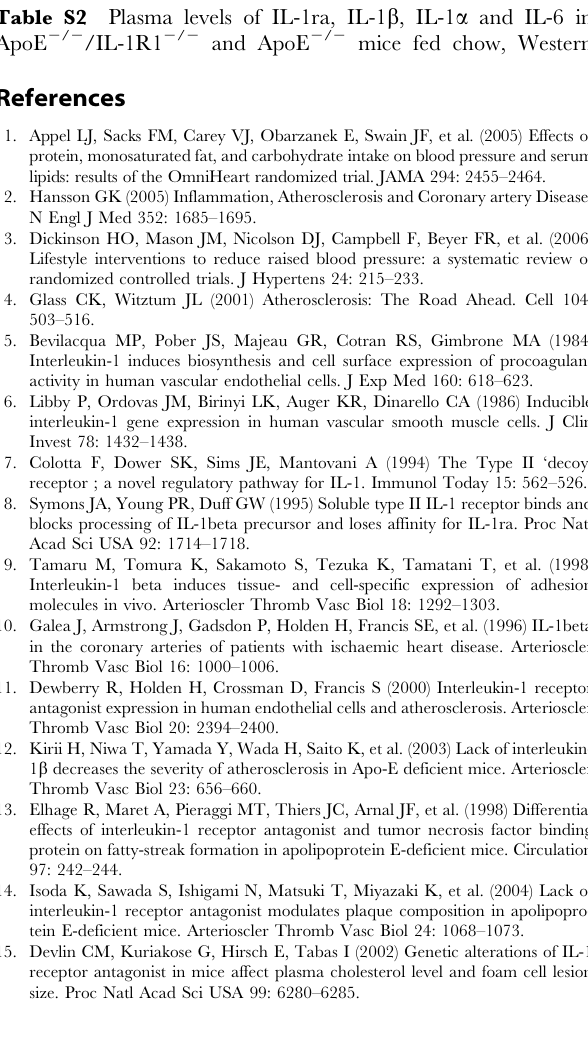
Table S3 Potency and efficacy of vasoconstrictor response to phenylephrine in pressurised mesenteric arterioles from Apoe 2 / 2 / IL1R1 2 / 2 and Apoe 2 / 2 mice fed a Western high cholate (WHC), Western, or Apoe 2 / 2 mice fed chow diet, assessed by pD2 (negative logarithm of EC50: concentration required for half maximum response) and Emax (percentage maximum constric- tion). All data are means + SEM. p =